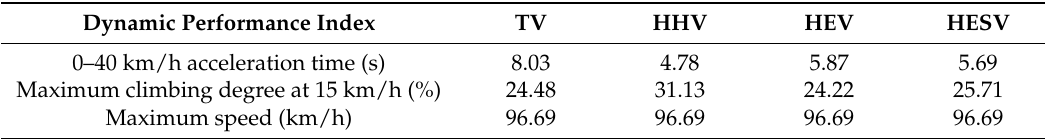
Table 3. Comparison of the dynamic performance of four vehicles. HHV: hydraulic hybrid vehicle; HEV: hybrid electric vehicle; HESV: hydraulic/electric synergy